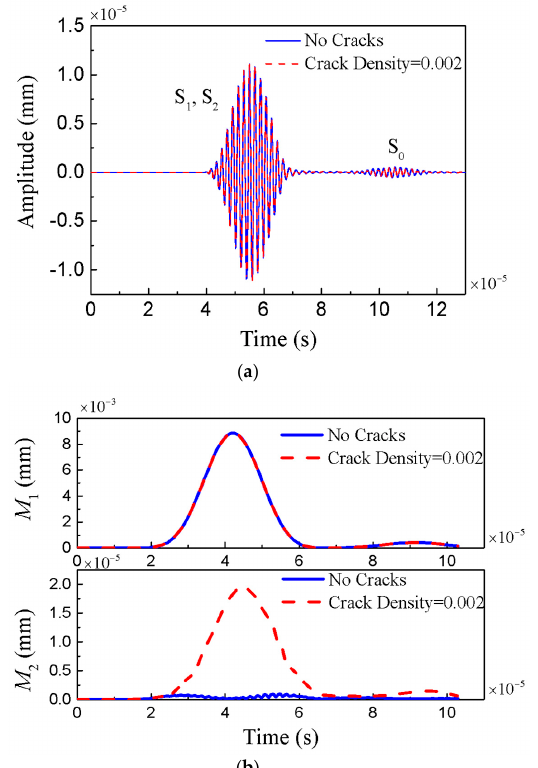
Figure 7. Lamb waves collected at position 1 in the x -direction. ( a ) In the time domain; ( b ) the spectrum graph sliced at the fundamental frequency 0.52 MHz and second harmonic frequency 1.04 MHz ( c = 0.002, μ = 0.3).